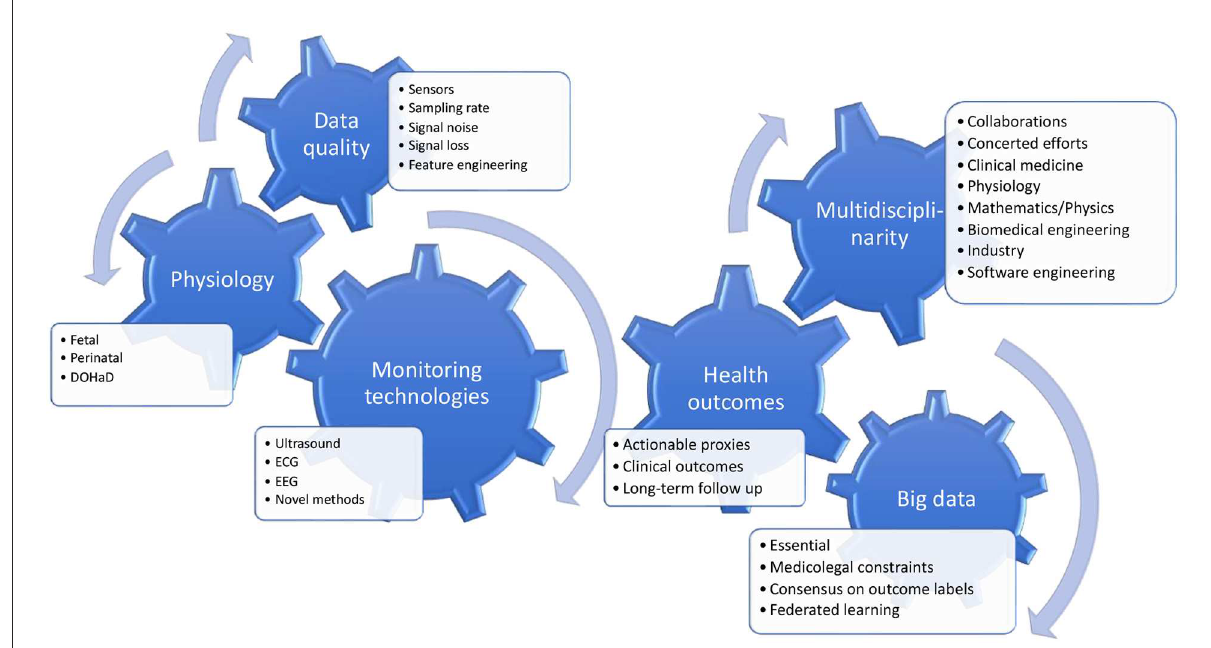
FIGURE1 Key insights from the Research Topic and future directions. There is a growing awareness of the antecedents of intrapartum fetal reserve for the trial of labor which require an integration of the physiology of whole pregnancy and the well-known relationships between intrauterine adversity on one hand, and the perinatal and postnatal developmental trajectories on the other hand (Developmental Origins of Health and Disease, the DOHaD concept). Another key insight is the requirement for clinically actionable outcome labels in the prediction models that are being developed and the recognition of the fundamental constraints on the data sizes of the individually accessible cohorts. Therefore, there is a clear need for multinational and multidisciplinary work to address the different challenges and research questions, which are all integral to successfully improving the technologies for intrapartum fetal